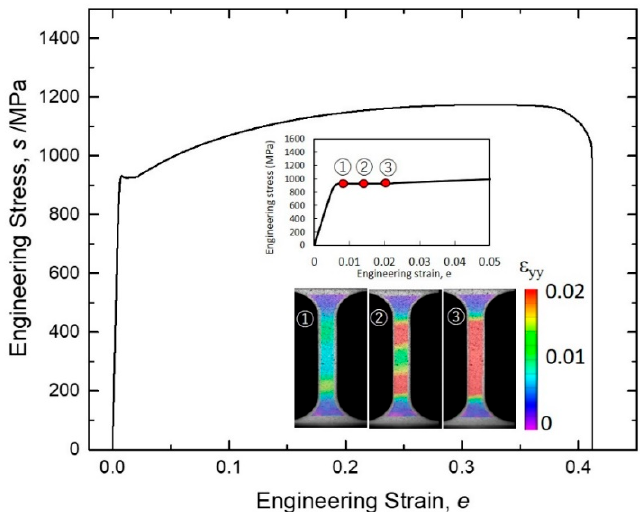
Figure 3. Nominal stress-strain curve of the UFG dual-phase Fe-20Mn-8Al-5Ni-0.8C alloy. The insets show the enlarged stress-strain curve at the beginning of tensile deformation and the corresponding strain contour on the surface of the specimen measured by the DIC method. The Lüders plateau can be clearly seen in the enlarged stress-strain curve, and the three strain contour maps corresponding to the points ① , ②, and ③ in the stress-strain curve show the initiation and propagation of the Lüders bands on the specimen.